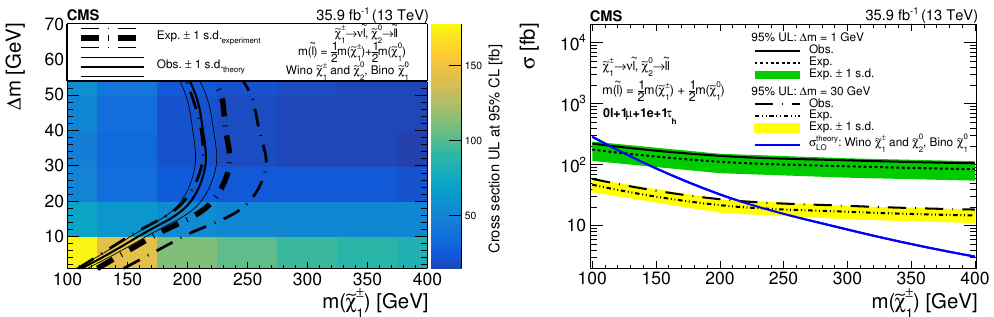
Figure 5 . (Left) Expected and observed 95% con(cid:12)dence level upper limit (UL) on the signal cross section as a function of m ( (cid:31) (cid:6) ) and (cid:1) m , assuming the light slepton model with slepton mass de(cid:12)ned e 1 as the average of the (cid:31) 0 and (cid:31) (cid:6) masses, x = 0 : 5. The lower left edge of each bin represents the e e 2 1 e ‘ f m ( (cid:31) (cid:6) ),(cid:1) m g combination used to calculate the UL on the signal cross section. For example, the e 1 lowest and leftmost bin corresponds to the UL on the signal cross section for the scenario with m ( (cid:31) (cid:6) ) = 100 GeV and (cid:1) m = 1 GeV. (Right) Combined 95% CL UL on the cross section as a e 1 function of m = m , for (cid:1) m = 1 GeV and (cid:1) m = 30 GeV mass gaps between the chargino and (cid:6) 0 2 e (cid:31) 1 e (cid:31) the neutralino, assuming the light slepton